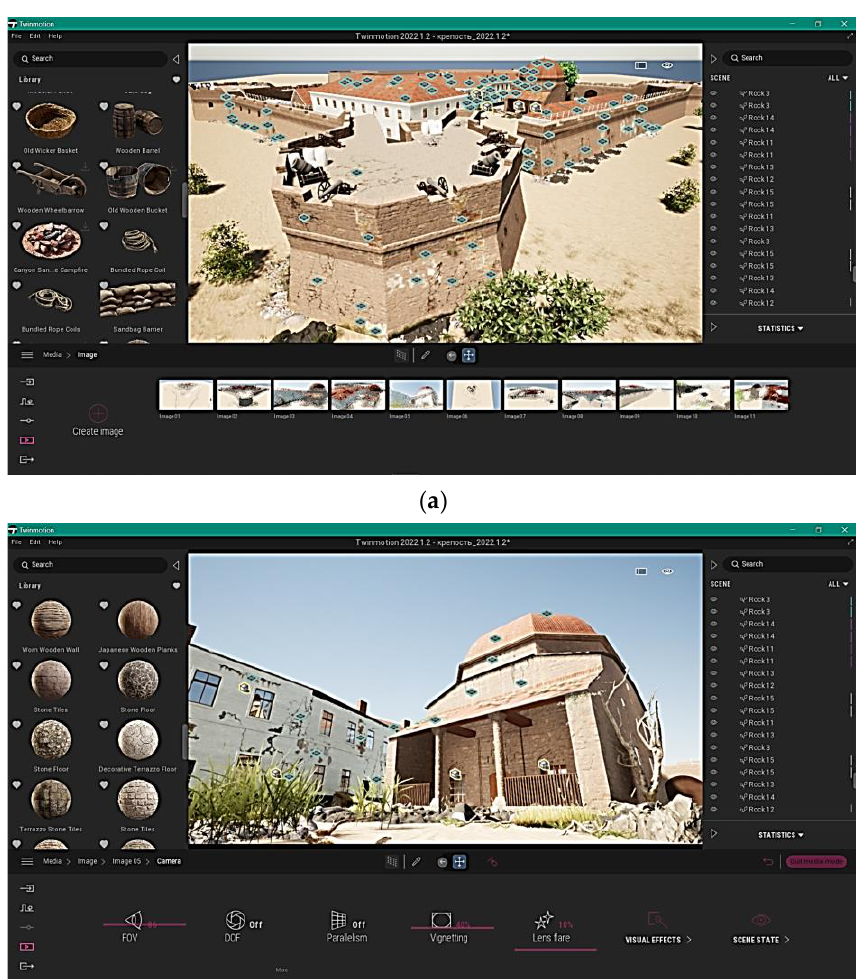
Figure 7. Creation of an authentic environment ( a ) and rendering ( b ).